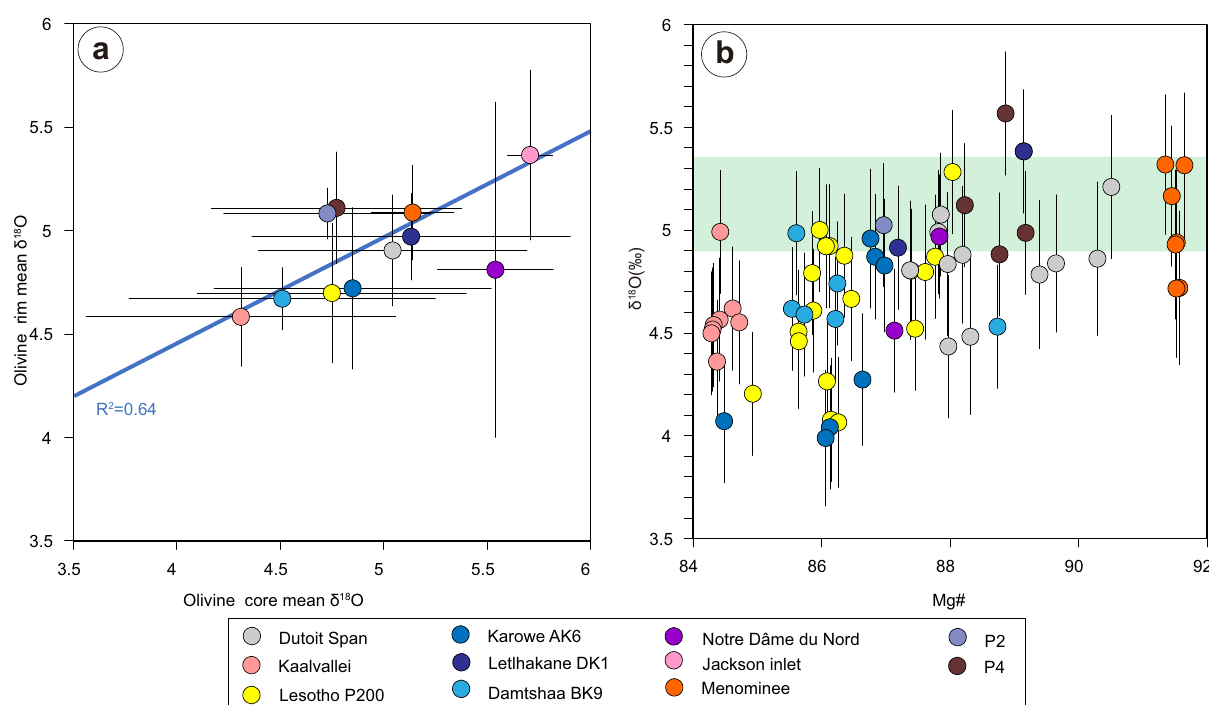
Fig. 7 Relationships between the oxygen-isotope composition of olivine rims and cores, and the major-element composition of olivine rims. a Average olivine rim δ 18 O versus average olivine core δ 18 O in the kimberlites (and lamproites) from this study. Error bars are one SD of the mean. The blue line is the linear regression through the data points (excluding the Notre Dâme du Nord outlier). b Covariation diagram showing a broad direct correlation between δ 18 O and Mg# in olivine rims from the examined samples. Error bars indicate the 2 σ of each